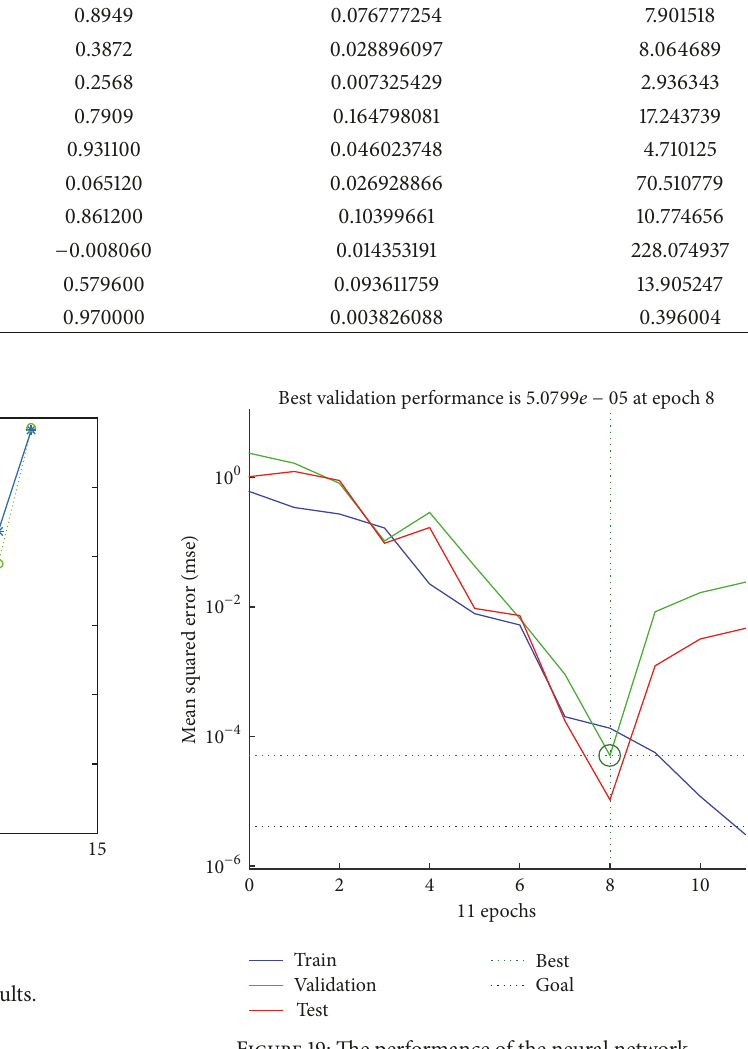
Figure 19: The performance of the neural